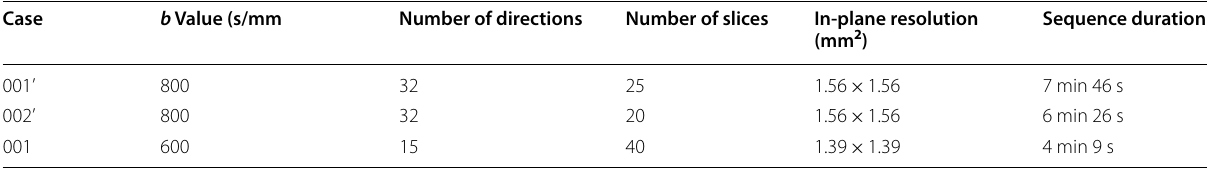
Table 2 Optimization of DTI acquisition parameters for the first three study patients Case b Value